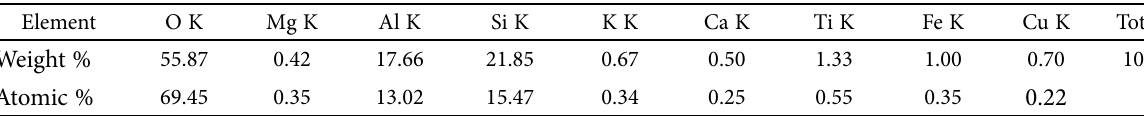
Table 2. Composition of fly ash